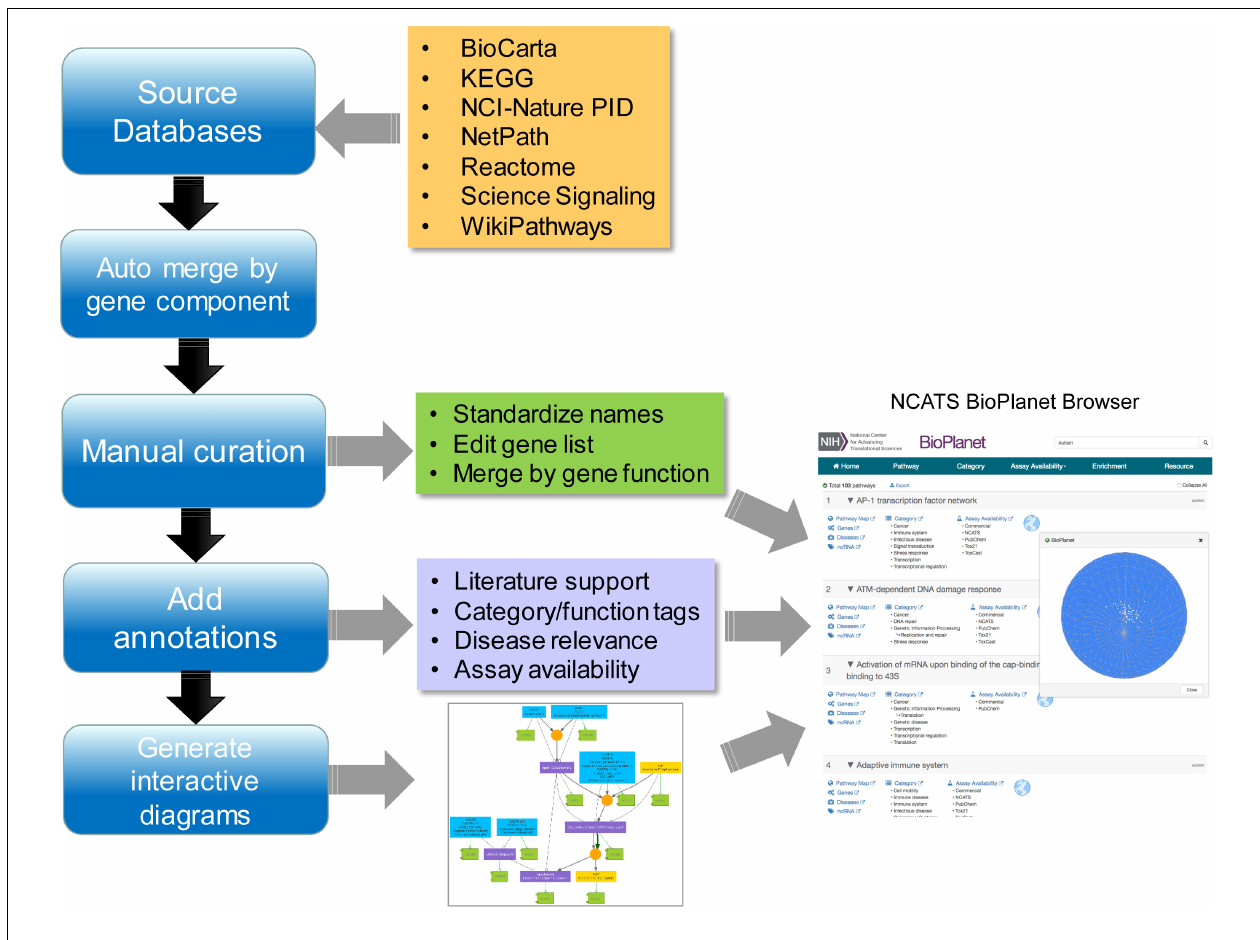
FIGURE 1 | Workflow for the NCATS BioPlanet construction process.